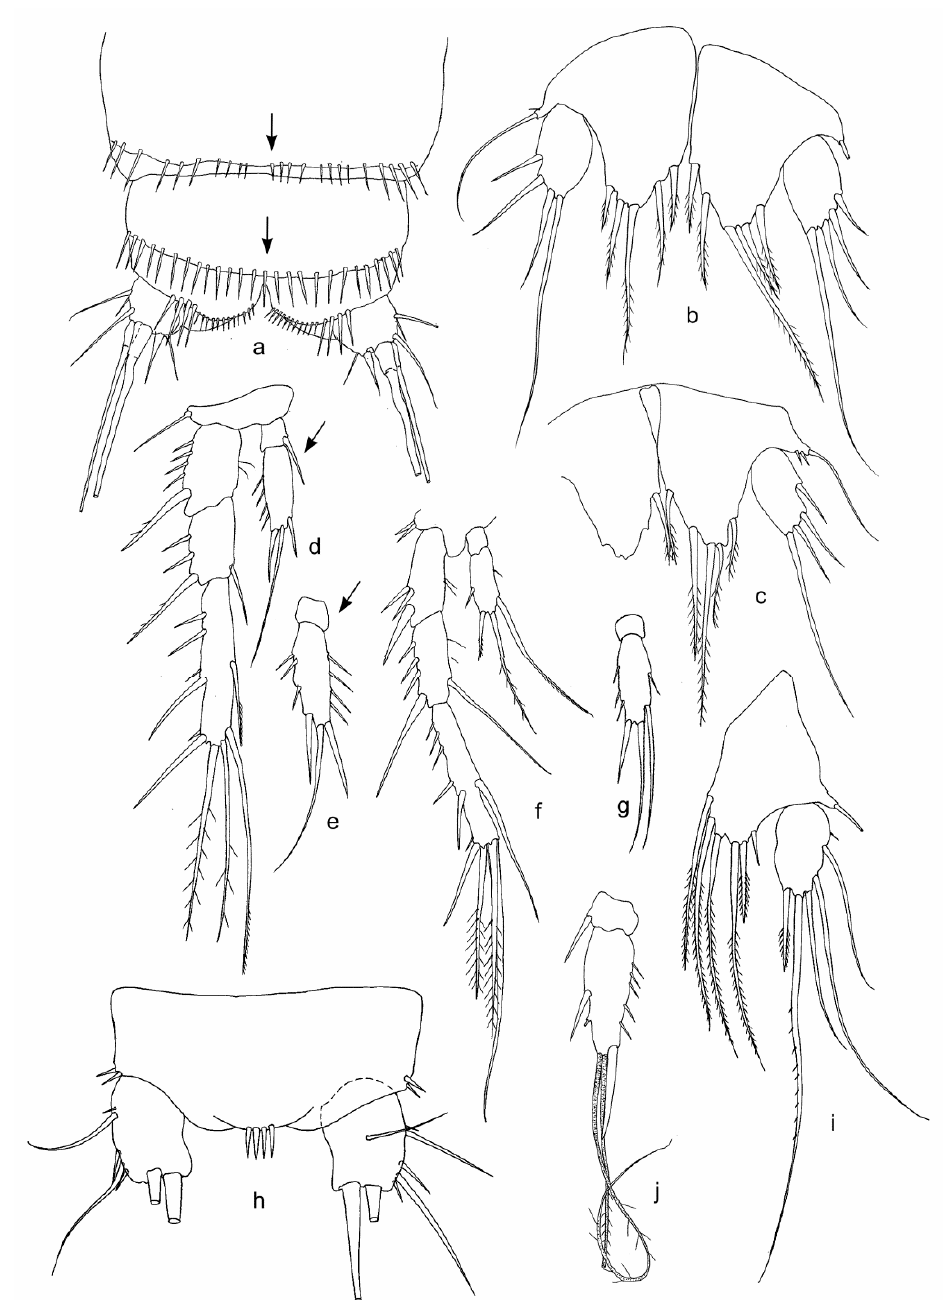
Figure 3. Features of females of Bryocamptus sp. 8 ( a – g ) and B. sinuatus ( h – j ) from Lake Baikal sites: Iz ( a , c , d , f ) and SPb ( b , e , g , h–j ). ( a )—caudal rami, ventral view; ( b , c , i )—P5; ( d )—P3; ( e , j )—P3 endopod; ( f )—P4; ( g )—P4 endopod; and ( h )—caudal rami, dorsal view. Abbreviations in Table 1. Some features are shown by arrows.